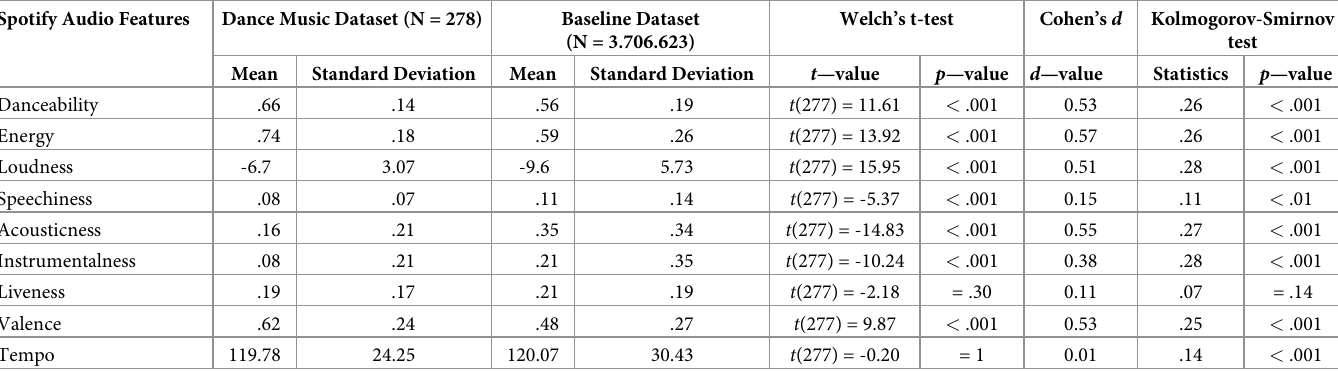
Table 1. Results of the two samples’ Welch’s t-tests, Cohen’s d and Kolmogorov-Smirnov tests between the dance and baseline music datasets. Spotify Audio Features